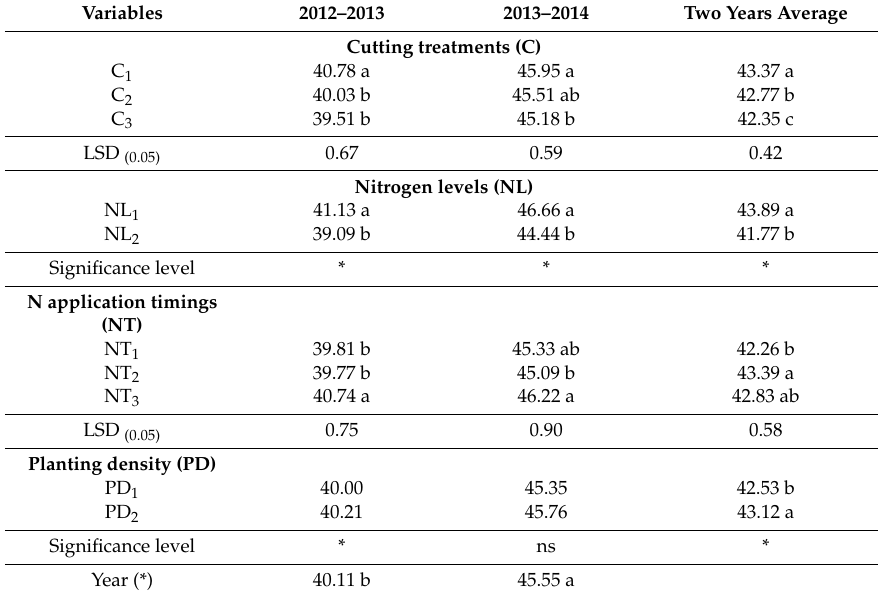
Table 5. Canola oil content (%) in response to cutting treatments, nitrogen levels and application timings under varying planting densities.